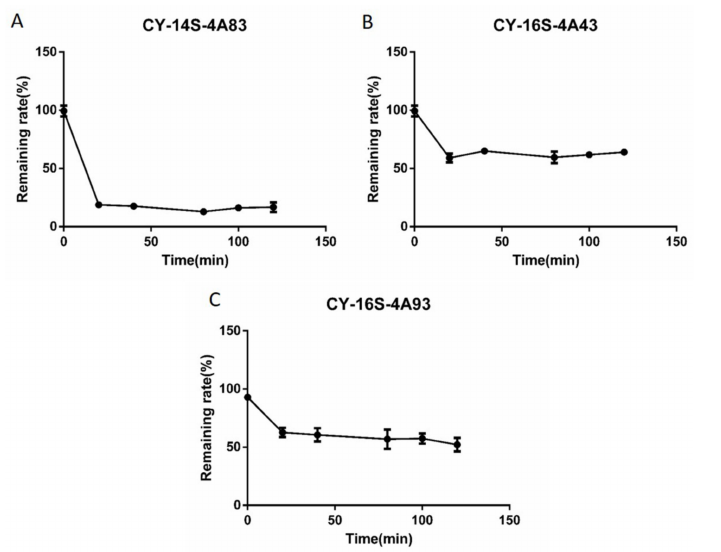
Figure 3. The respective remaining rates of the disappearance of CY-14S-4A83 ( A ), CY-16S-4A43 ( B ), and CY-16S-4A93 ( C ) at 0, 20, 40, 80, 100, and 120 min via rat liver